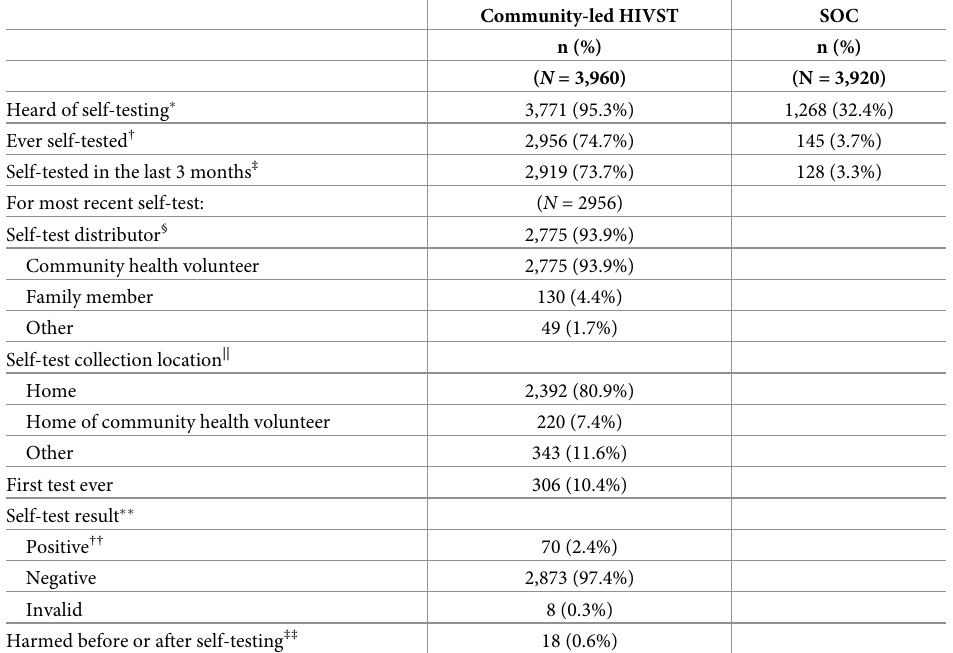
Table 4. Fidelity to community-led HIV self-testing